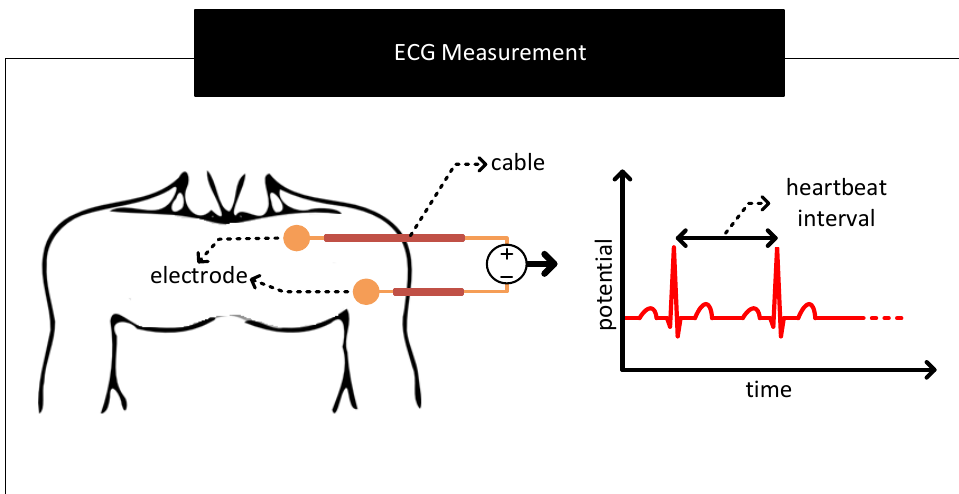
Figure 13. A sample scheme to measure human heart activity. The scheme uses two electrodes attached to the surface of the chest and separated by a distance to measure the biopotential signals associated with the heart activity. Differencing the signal voltages from the electrodes yields the characteristic electrocardiogram (ECG)